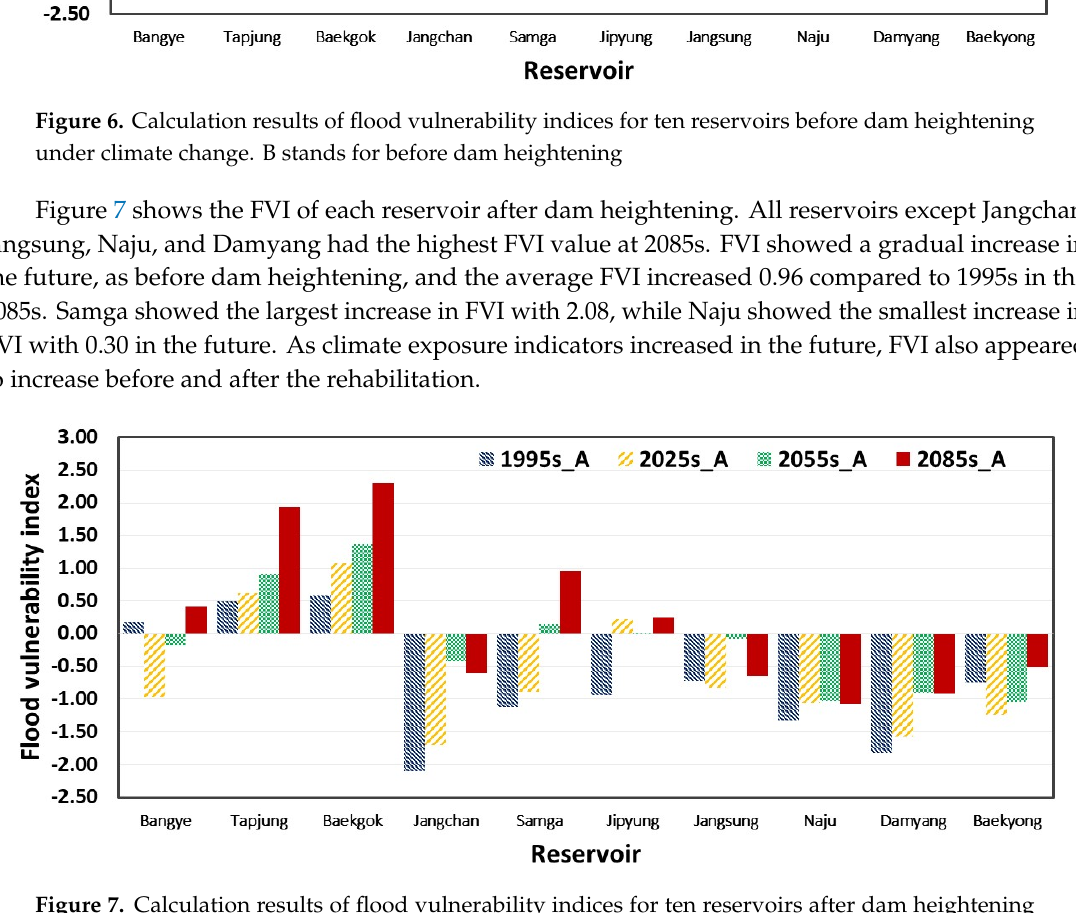
Figure 7. Calculation results of flood vulnerability indices for ten reservoirs after dam heightening under climate change. A stands for after dam heightening